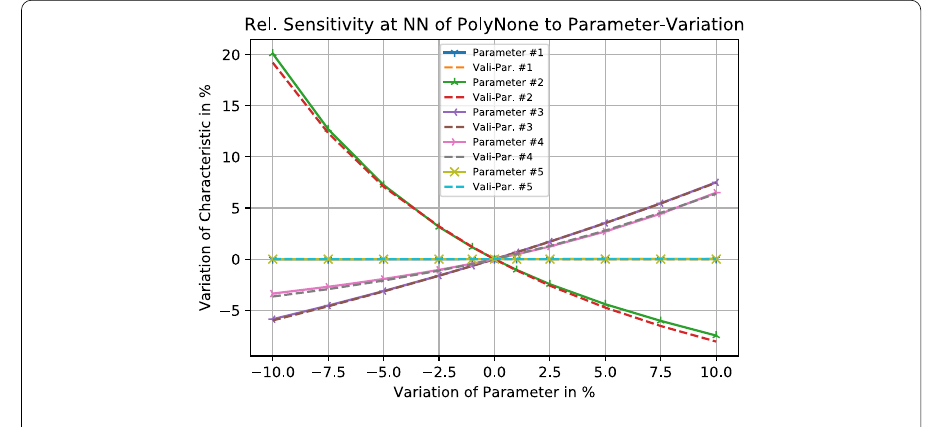
Fig. 35 Rel. sensitivity for the